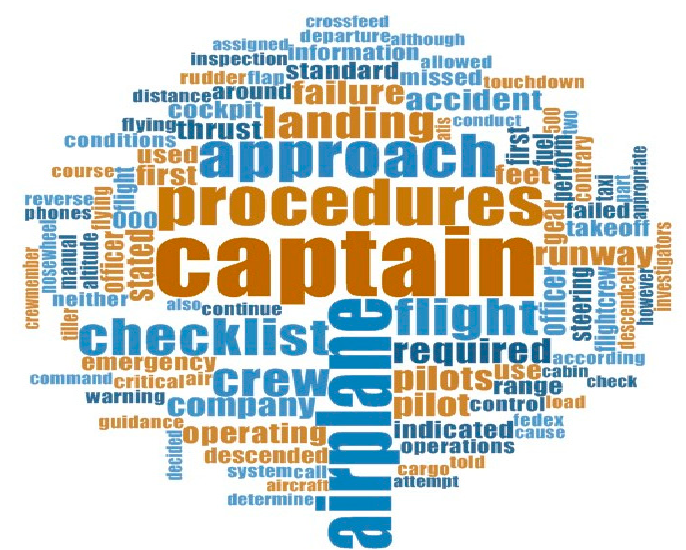
Figure 4. Tag cloud helps visualize the word query for Neglect of Flight Planning, Preflight Inspections, and Checklists. Table 5. Examples of Peer